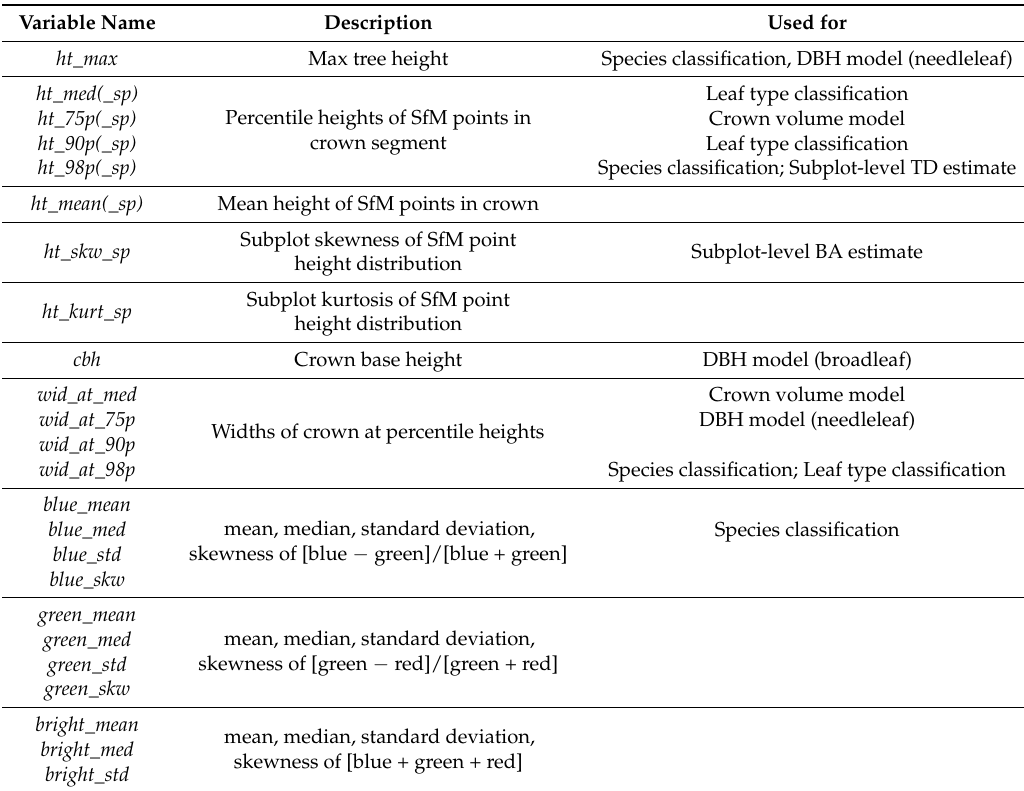
Table 2. Variables calculated using structure from motion (SfM) point cloud structural and spectral